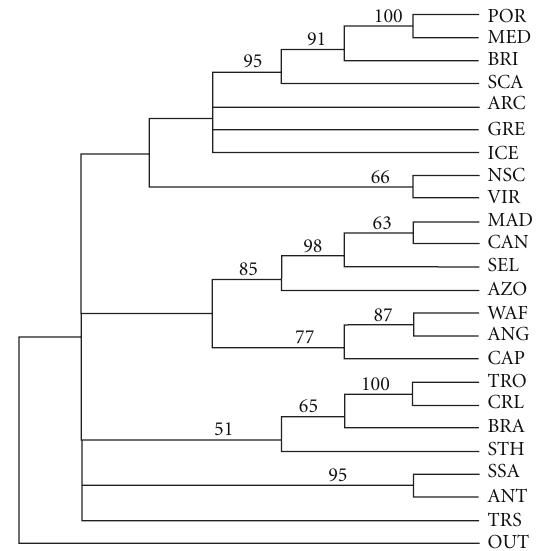
Figure 1: Consensus tree with bootstrap values for the shallow Ris- soidae species.